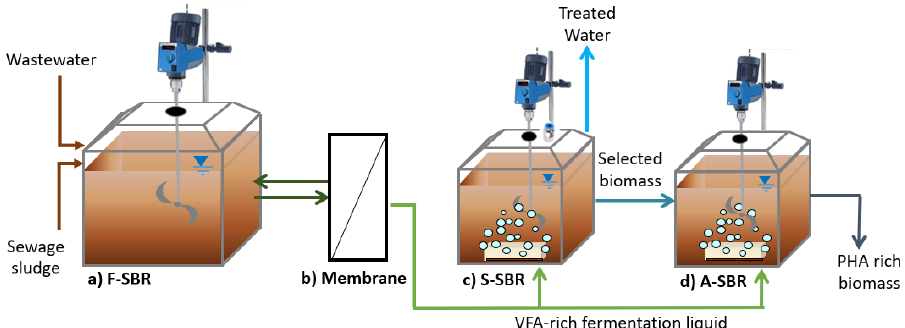
Figure 4. PHA pilot plant configuration. ( a ) Sequencing batch fermentation reactor (F-SBR), ( b ) Ultrafiltration membrane, ( c ) selection sequencing batch reactor (S-SBR) and ( d ) accumulation sequencing batch reactor (A-SBR).